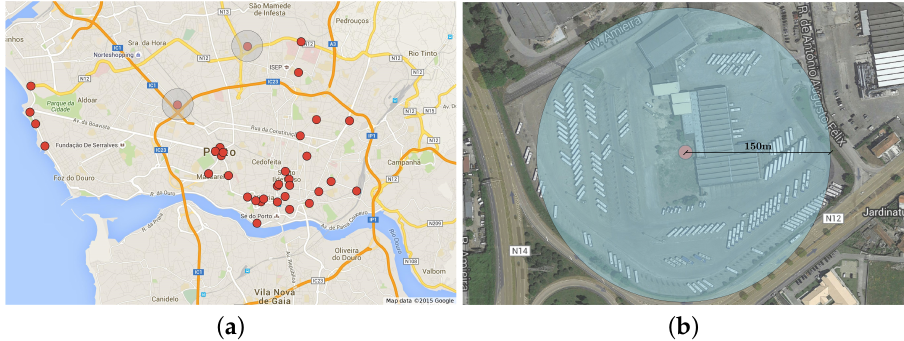
Figure 8. Parking lot scenario. ( a ) Overview; ( b ) Zoom in the parking lot around RSU 447.